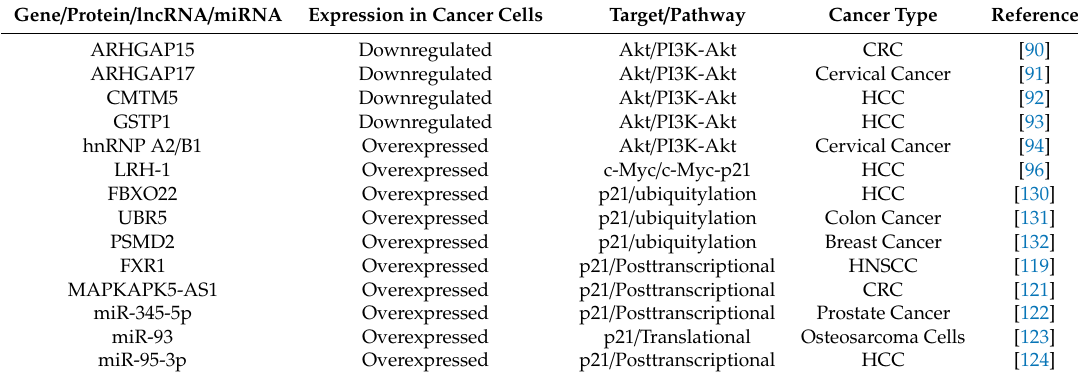
Table 3. Di ff erentially expressed genes and RNAs in di ff erent cancer types and their target pathways are shown